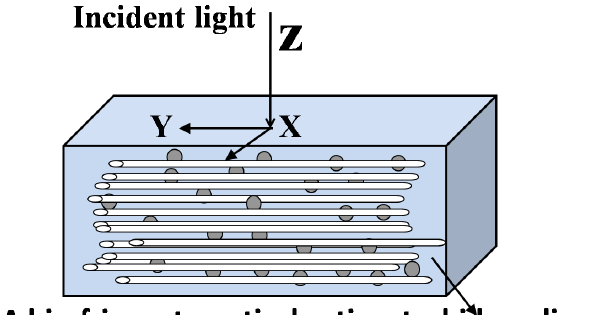
Fig. 1. Schematics of the scattering model for biological